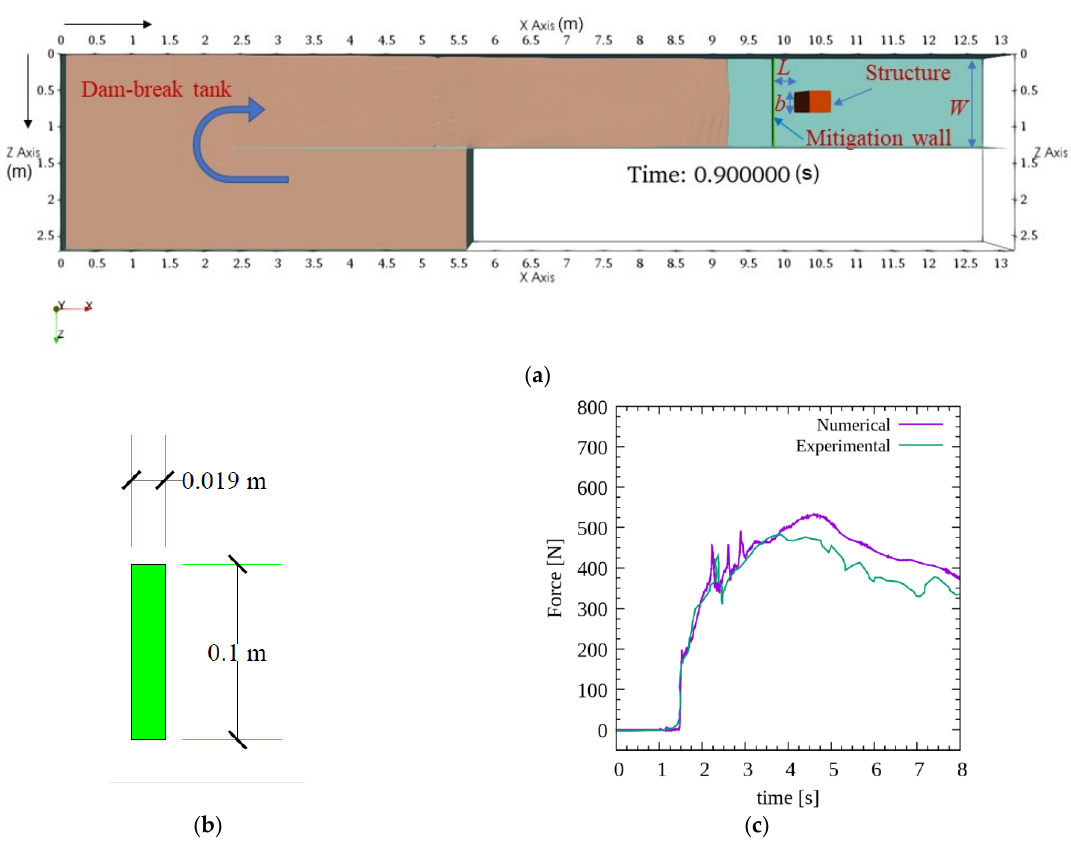
Figure 1. ( a ) Numerical wave tank showing the plan view of the mitigation wall and the structure; ( b ) sectional view of the mitigation wall (VW); ( c ) comparison of experimental and numerically estimated force.